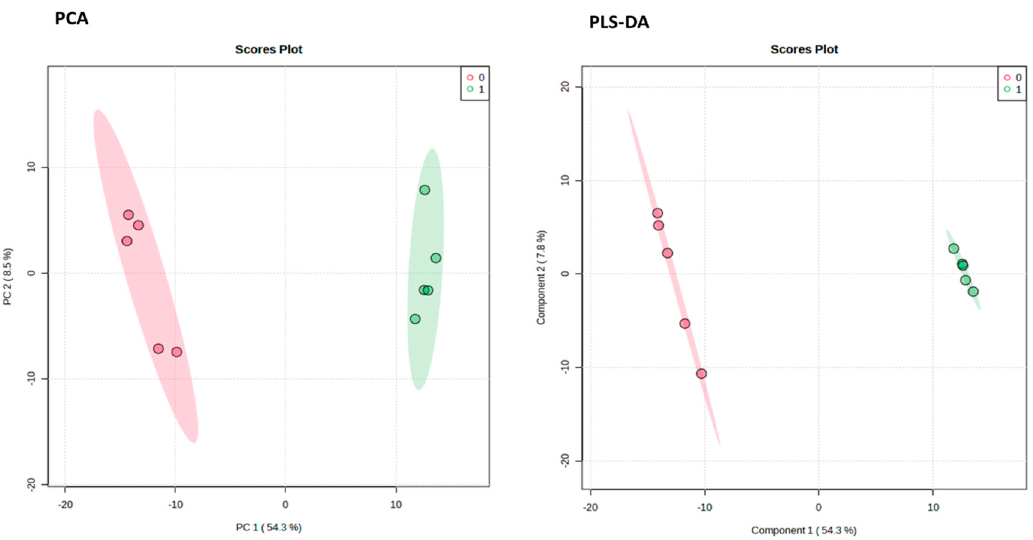
Figure 3. Pairwise analysis of metabolomic data using principal component analysis ( PCA ) and partial least squares–discriminant analysis ( PLS - DA ). Red and green represent the data from the control and metronidazole treatments, respectively.